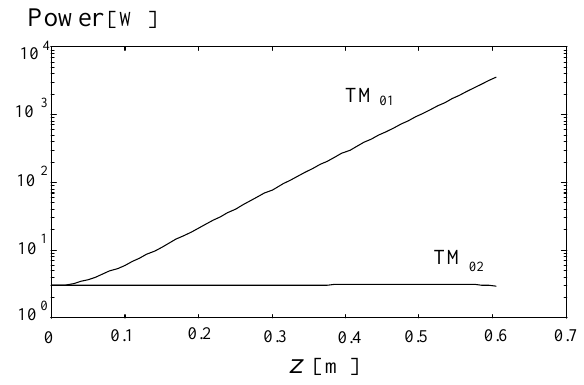
FIG. 5. Calculated output power of TM (cid:48)(cid:49) and TM (cid:48)(cid:49) modes as a function of (cid:122) . error in the radial angle measurement of , (cid:50) –